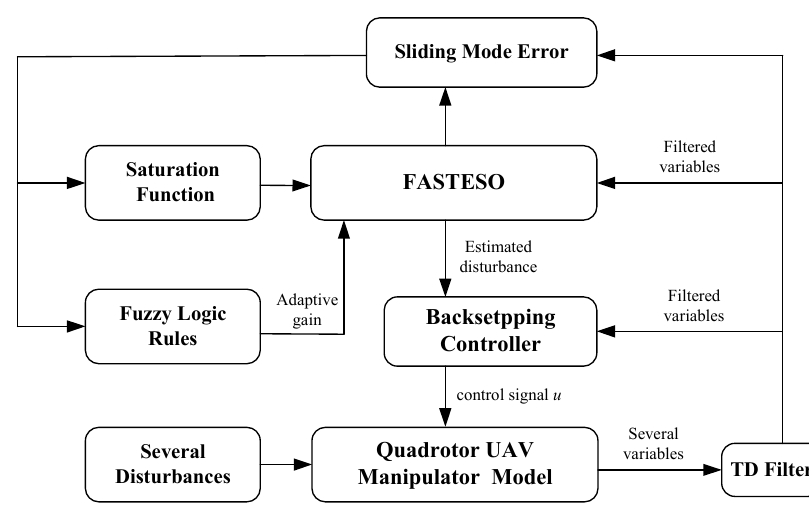
Figure 2. Whole control structure of the proposed